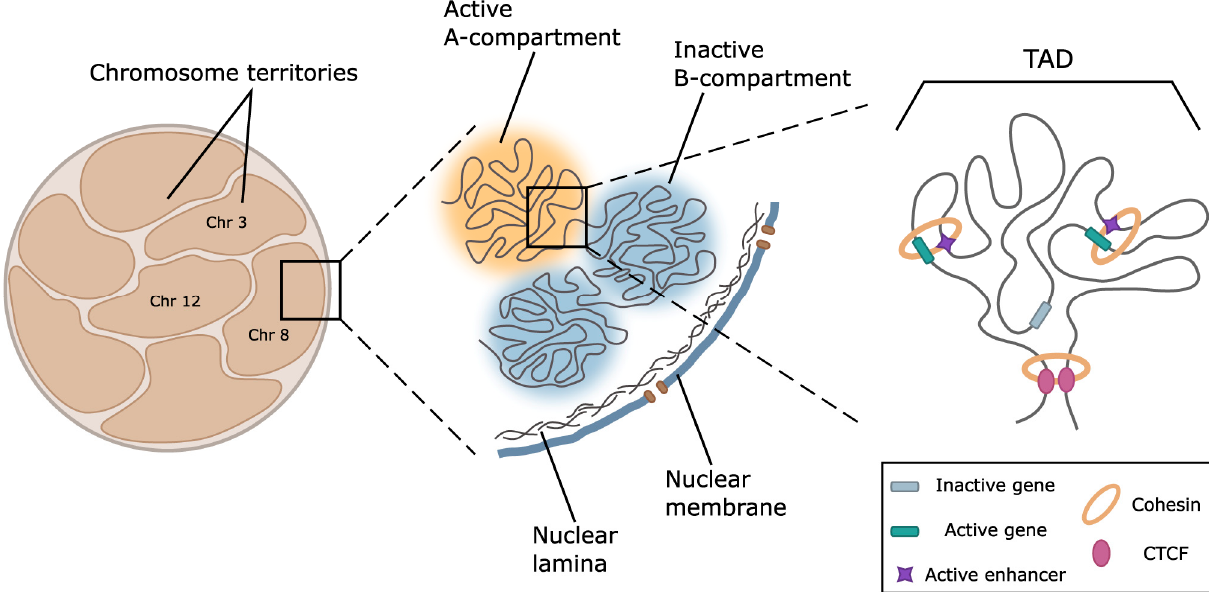
Figure 3. Schematic representation of the major levels of 3D genome organization. At the level of the whole nucleus and within chromosome territories, active and repressed genome loci are spatially segregated within A- and B-compartments. These structures are formed by large-distant contacts between regions possessing similar profiles of epigenetic marks. Regions forming inactive compartments tend to locate at the nucleus periphery, where they establish contact with the nuclear lamina. At the level of 100–1000 kb, chromosomes are folded into globular topologically associated domains (TADs). In mammals, TADs are predominantly formed by cohesin-driven chromatin extrusion, frequently terminating at CTCF-binding sites. In a number of well-characterized genome loci, TAD boundaries restrict the areas of enhancer action allowing regulatory systems to activate genes located within a TAD. According to the current paradigm, activation is provided by loop formation between the enhancer and cognate promoter.